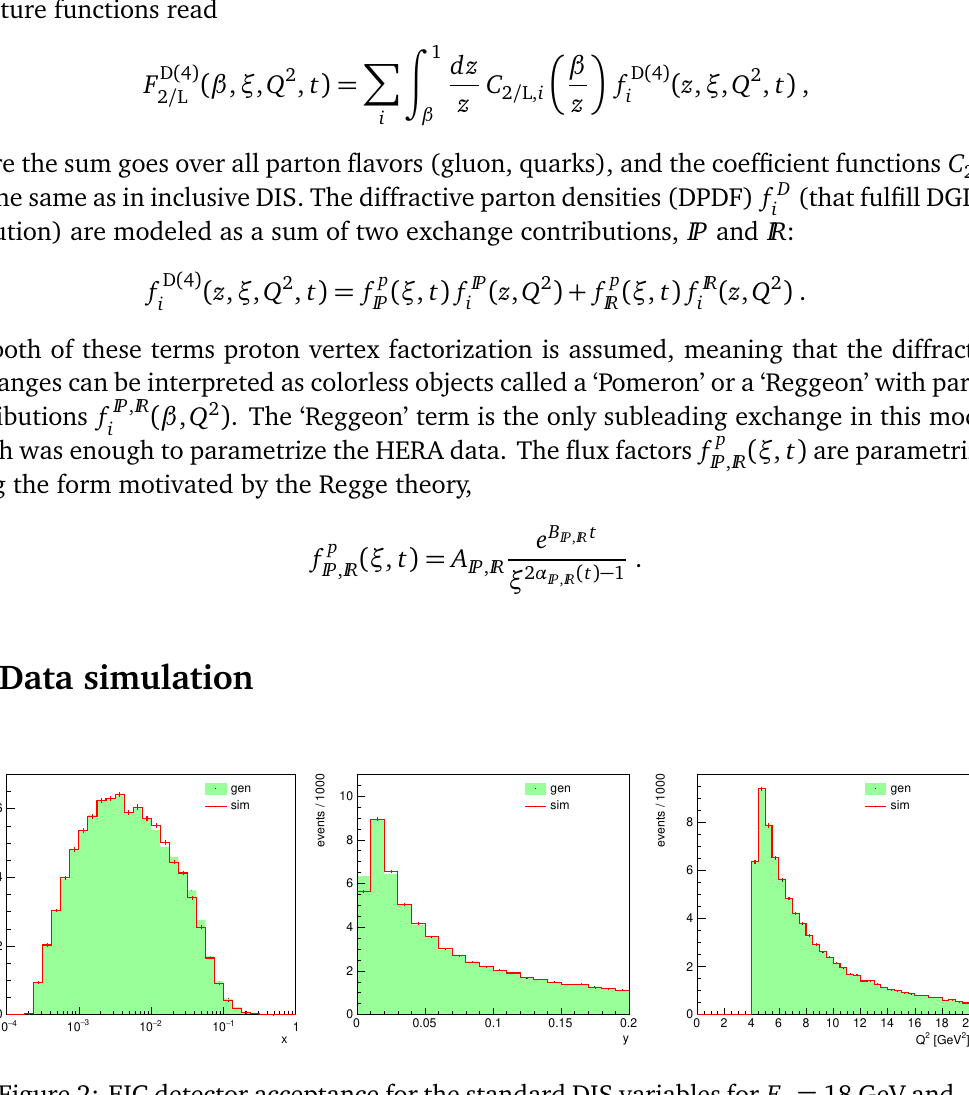
Figure 2: EIC detector acceptance for the standard DIS variables for E = 275 GeV. Green area — Rapgap generated data; red histograms — reconstructed E p from the detector smeared data.